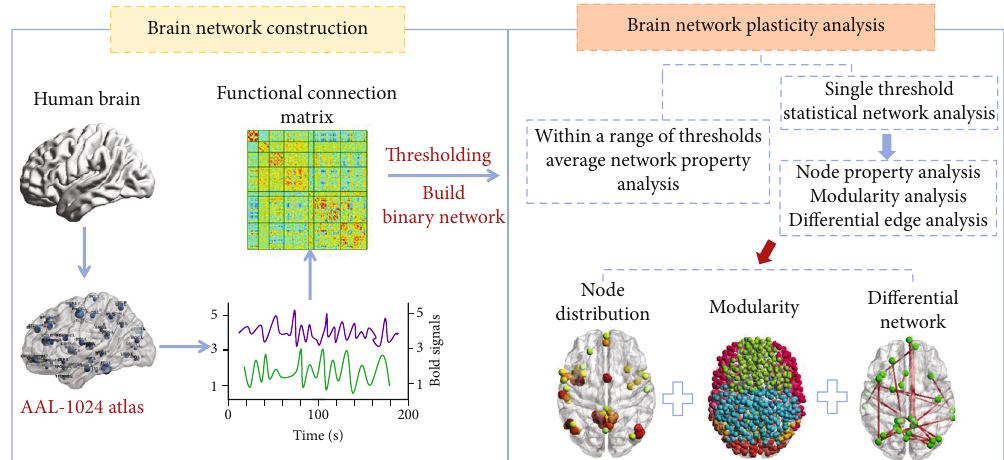
Figure 1: The fl owchart of the analysis